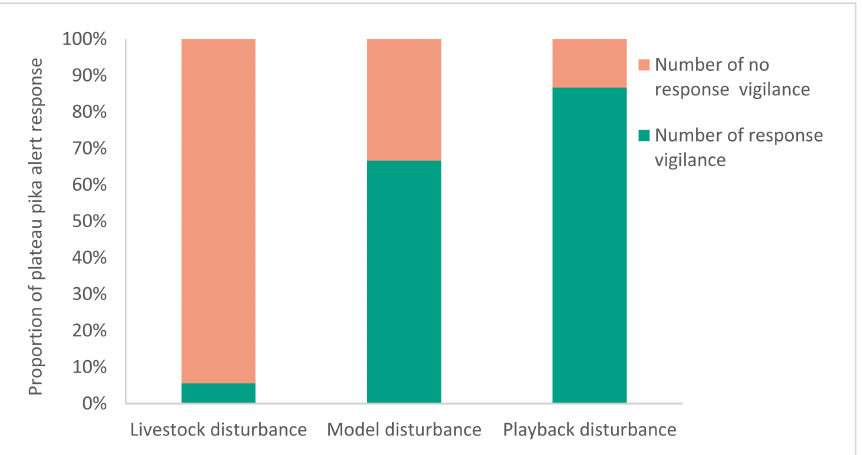
Figure 5. The stimulation experiment is divided into three types (livestock, model, playback). The number of livestock tests was n = 18 (9 consecutive days, once in the morning and once in the afternoon); the number of model tests was n = 15 (3 continuous days, 5 times a day at random); and the number of playback tests was n = 15 (3 consecutive days, 5 times a day at random).